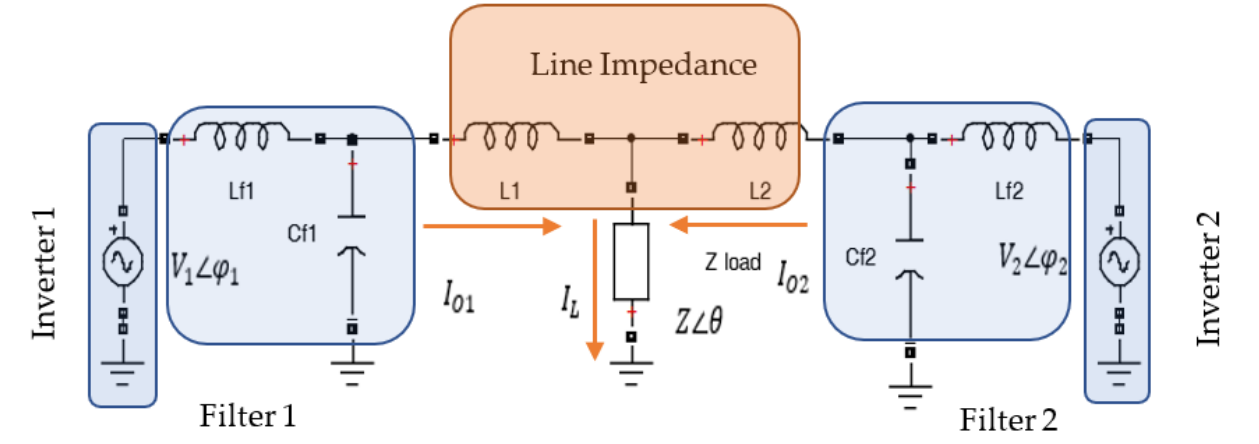
Figure 3. Equivalent block diagram of two inverters in the microgrid.